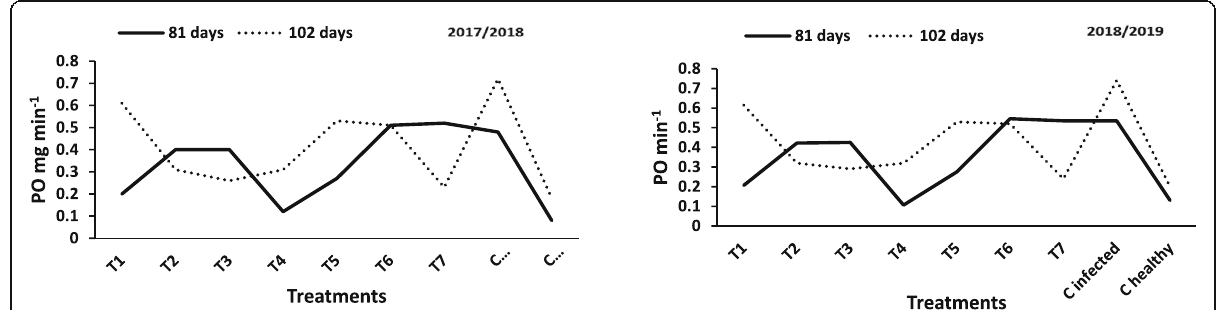
Fig. 6 Peroxidase (PO) activities for different treatments at two seasons. T1 = AgNps 50 ppm, T2 = AgNps 75 ppm, T3= AgNps 100 ppm, T4 = Spirulina 50%, T5 = Spirulina 75%, T6 = Spirulina 100% and T7 = Bacillus subtilis %